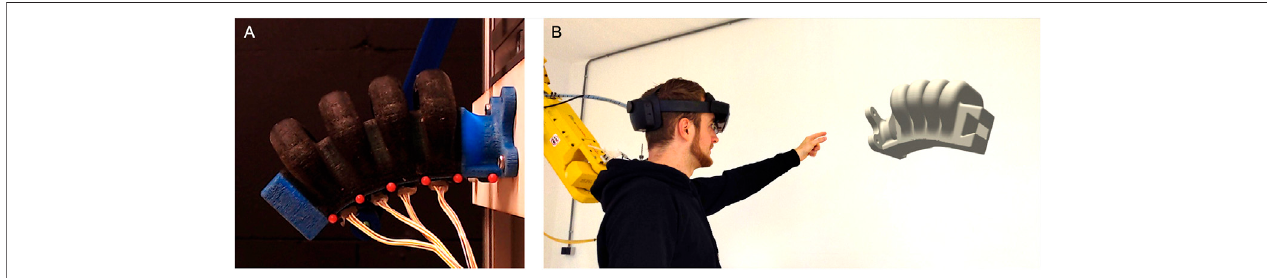
FIGURE 1 | (A) Sensorized Soft Actuator with embedded color sensors for proprioception (B) A real-time digital twin of the deformed soft actuator in augmented reality based on the measurements from the proprioceptive